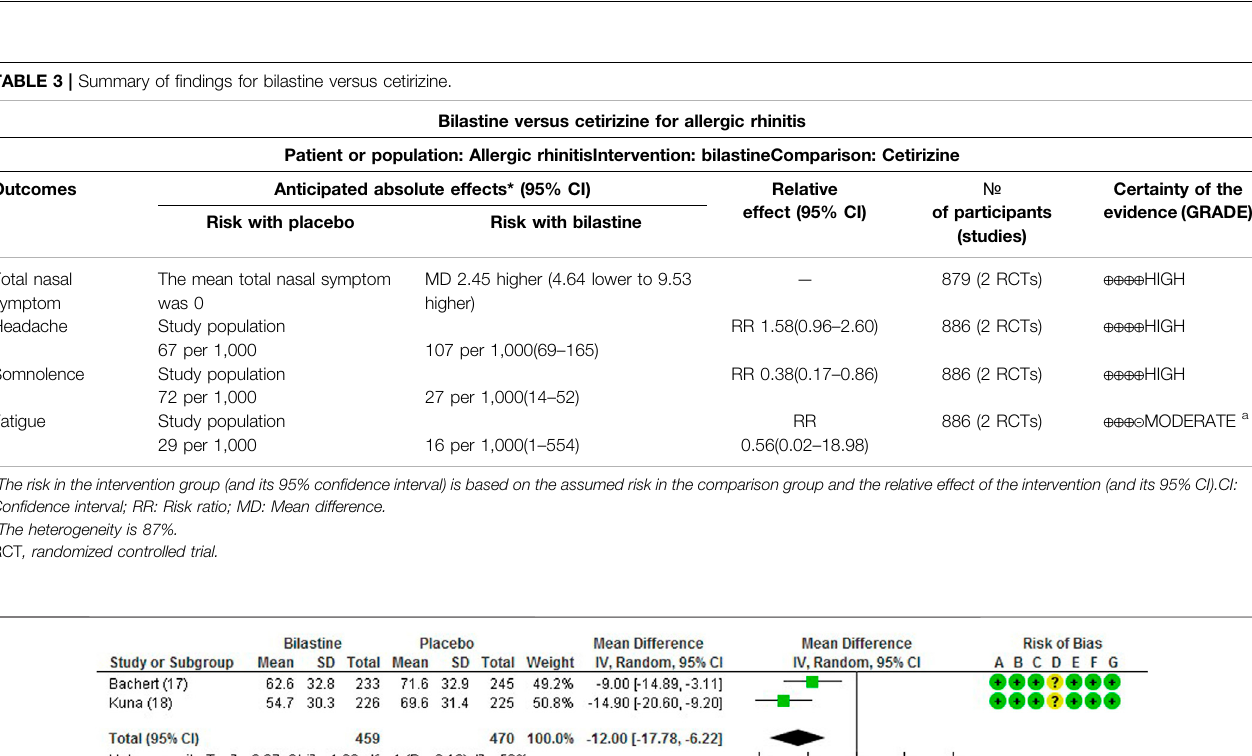
FIGURE4| Comparison betweenbilastine and cetirizine fortotalsymptomscore. SD Standarddeviation, IV inversevariance, CI Con fi dence interval, df degreesof freedom.